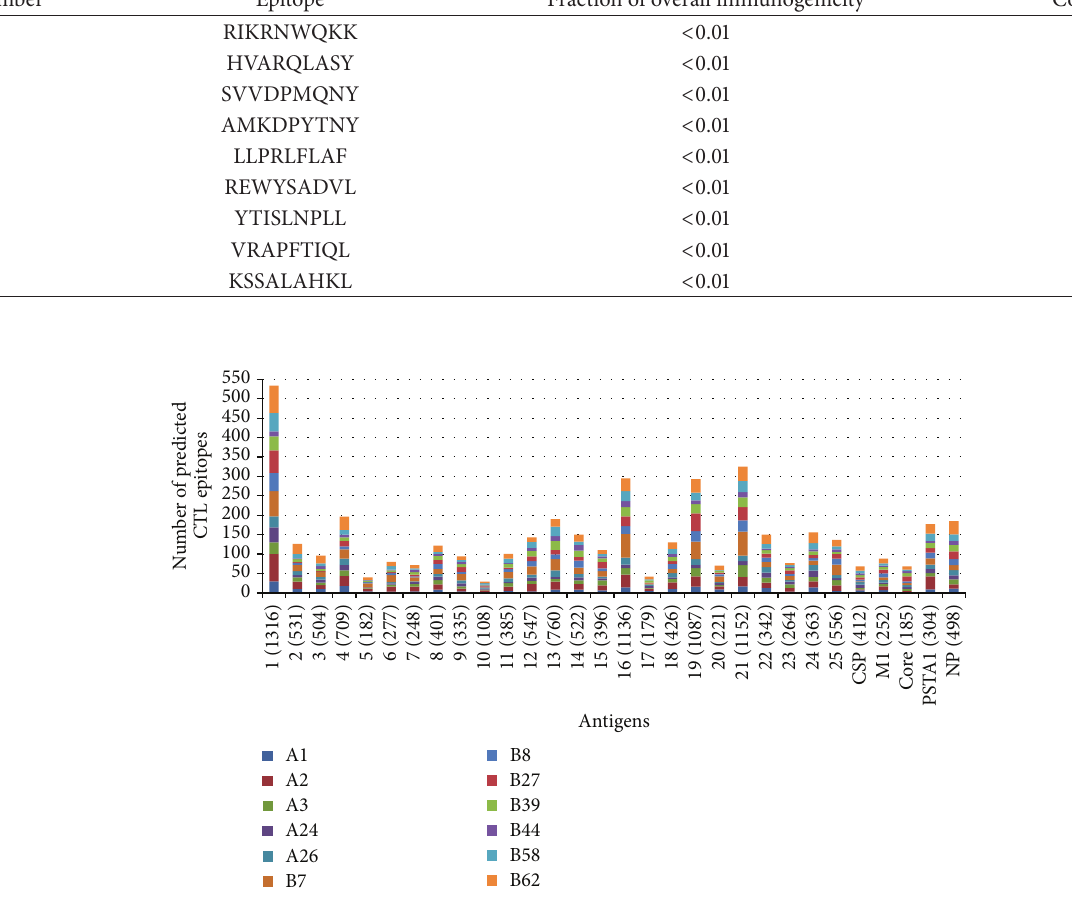
Figure 2: Graphical representation of CTL epitopes predicted by NetCTL for the 25 potential L. major antigens and 5 control antigens (CSP, M1, core, PSTA1, and NP), which bind with at least one allele in the HLA-A (A1, A2, A3, A24, and A26) and HLA-B (B7, B8, B27, B39, B44, B58, and B62)